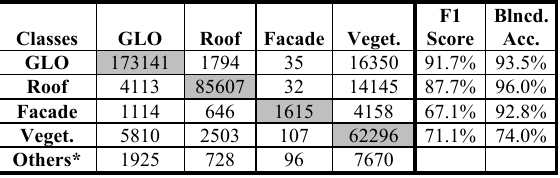
Table 5. 2D CNN classification results for Vaihingen set and confusion matrix with accuracy measures, overall accuracy 86.4% excluding others, 84.1% including others. Others* include points from removed classes (powerline, cars and fence classes removed from the training set) which are classified as GLOs, roof, façade or vegetation.